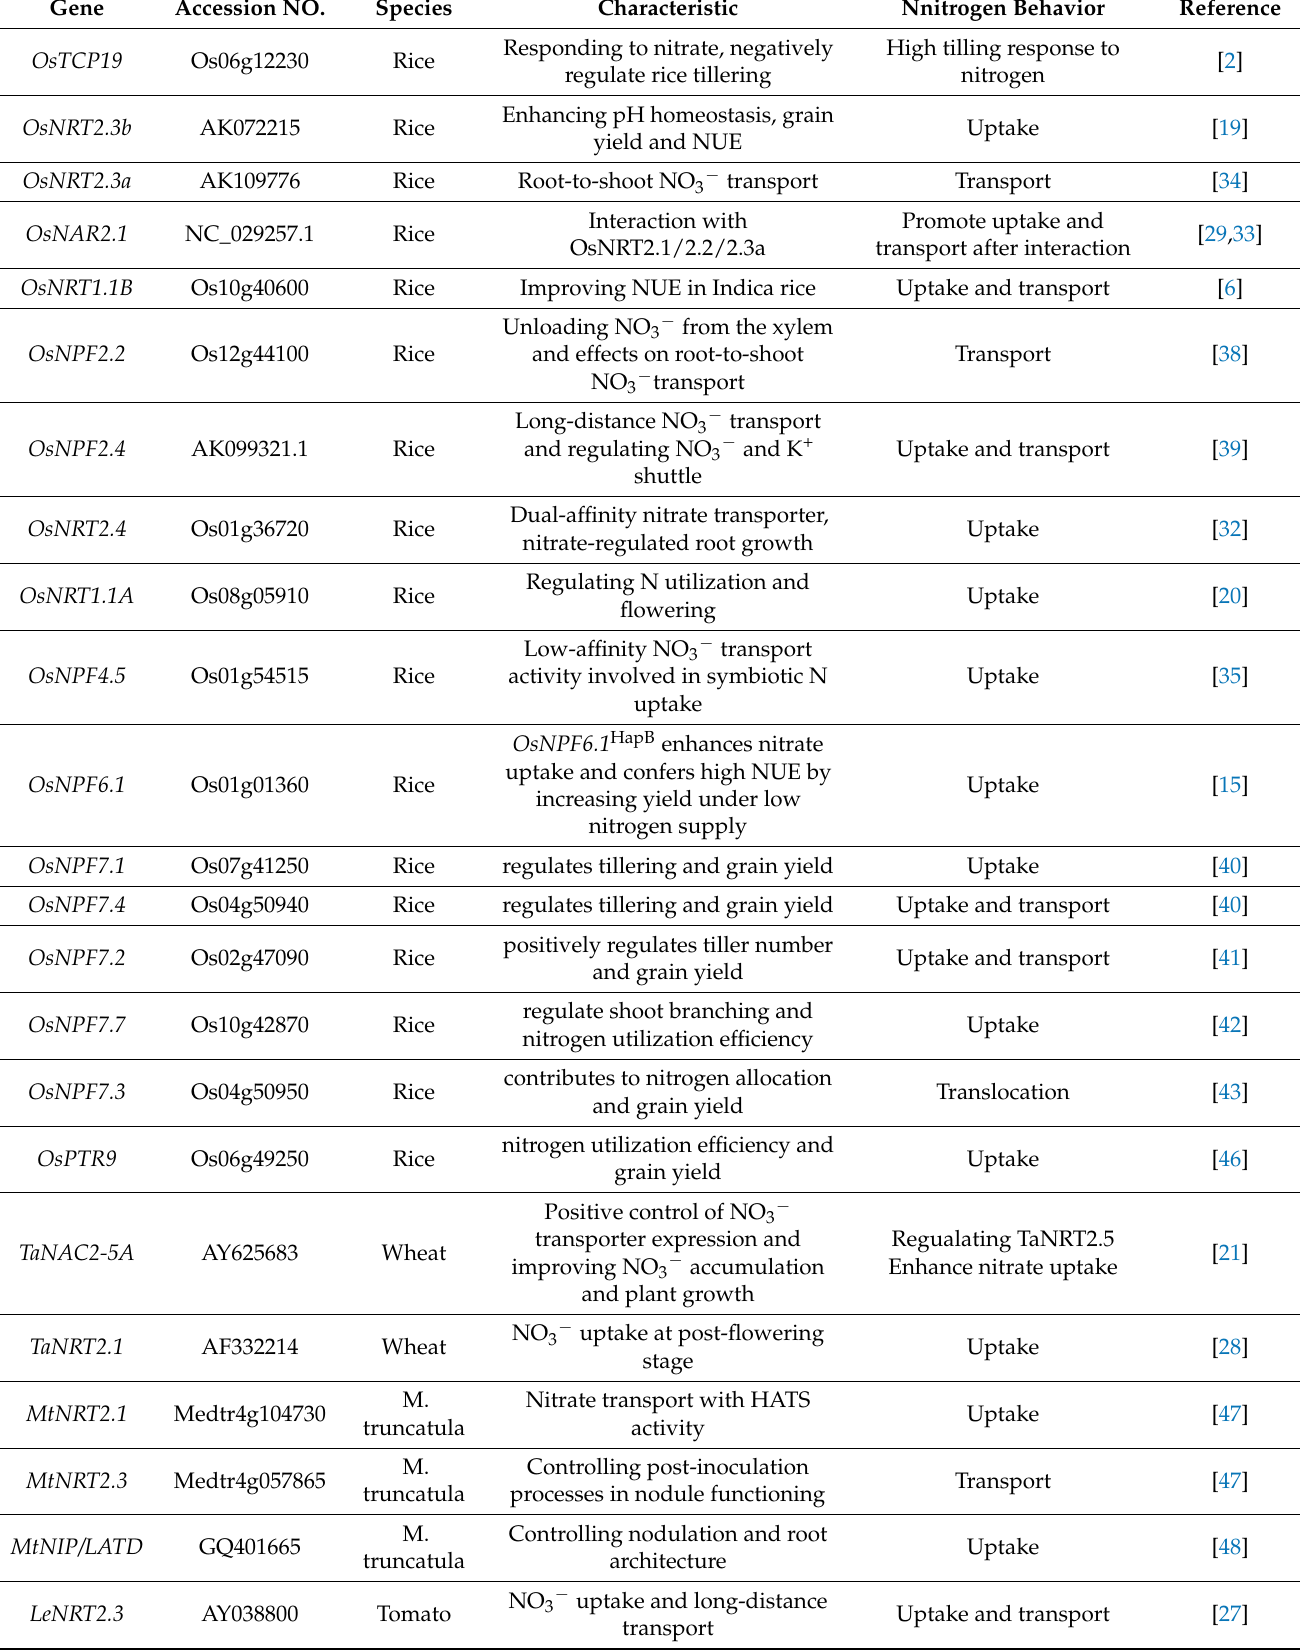
Table 1. Candidate NO 3 − transporter and regulation genes for crop application. NUE, nitrogen use efficiency.